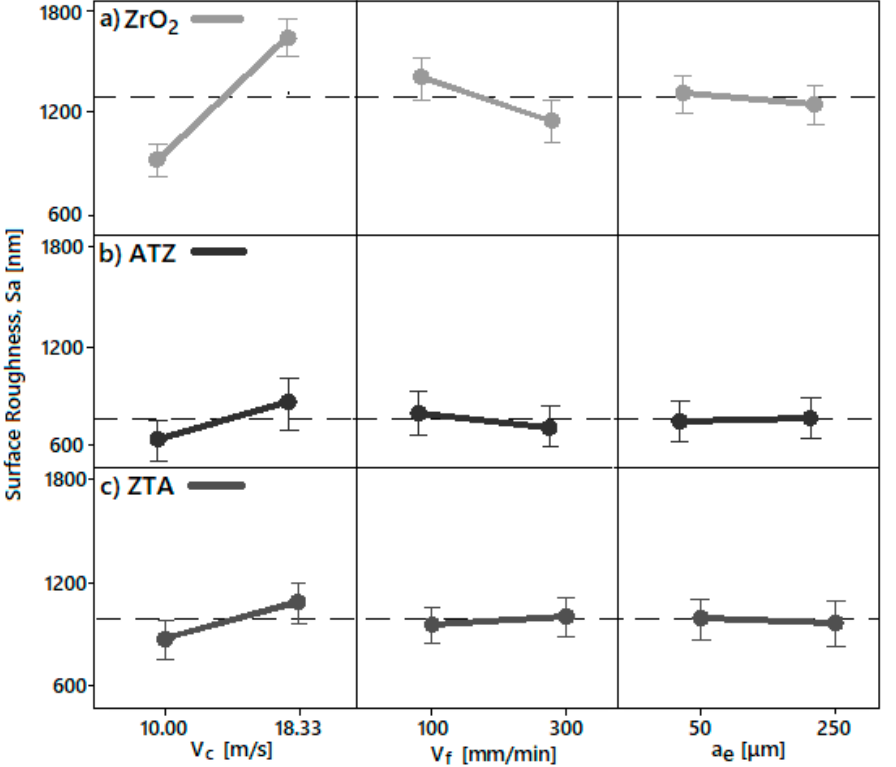
Figure 9. The main e ff ect diagram for surface roughness (Sa) of ( a ) ZrO 2 , ( b ) ATZ, and ( c ) ZTA in regard to peripheral speed (v c ), feed rate (v f ), and depth of cut (a e ).